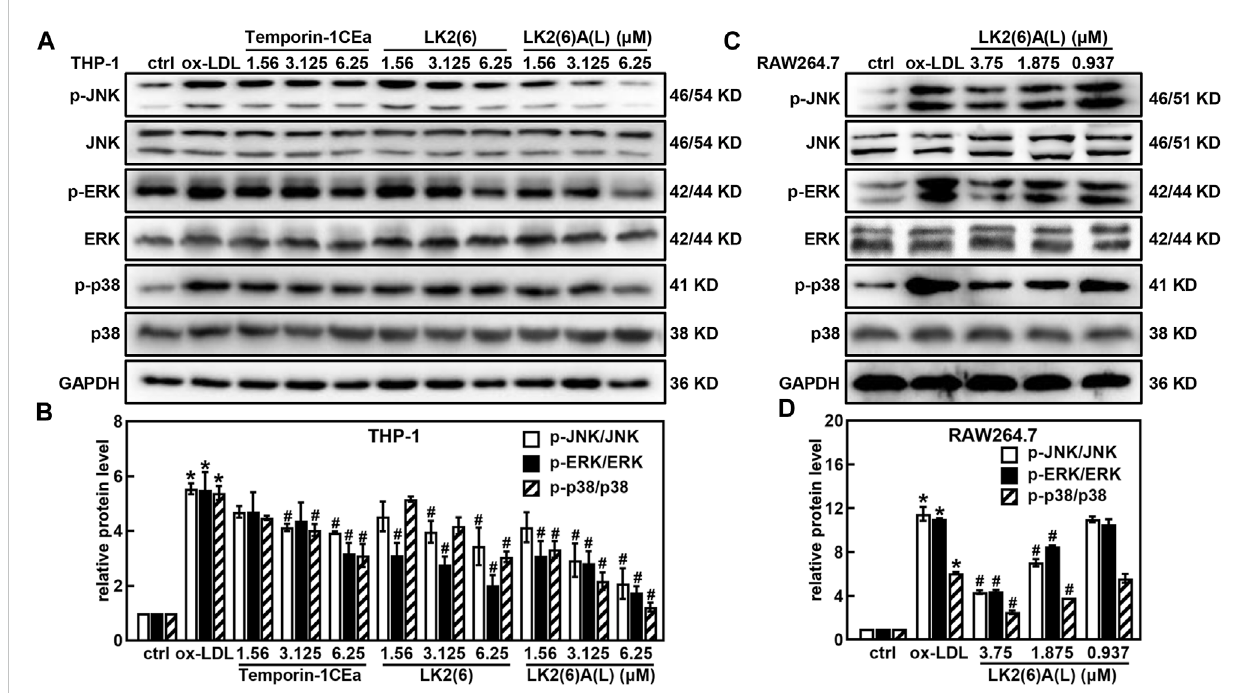
FIGURE 6 EffectsoffrogskinAMPsontheproteinexpressionofMAPKsignalingpathwayinox-LDLinducedfoamcells.Expressionof p- JNK,JNK, p- ERK,ERK, p- p38 and p38 protein in the foaming THP-1 cells treated with temporin-1CEa and its analogs by Western blot (A,B) ; Expression of p- JNK, JNK, p- ERK, ERK, p- p38 and p38 protein in the foaming RAW264.7 cells treated with LK2(6)A(L) by Western blot (C,D) and GAPDH was used as an internal reference. * p < 0.05 vs. the ctrl group. # p < 0.05 vs. the ox-LDL